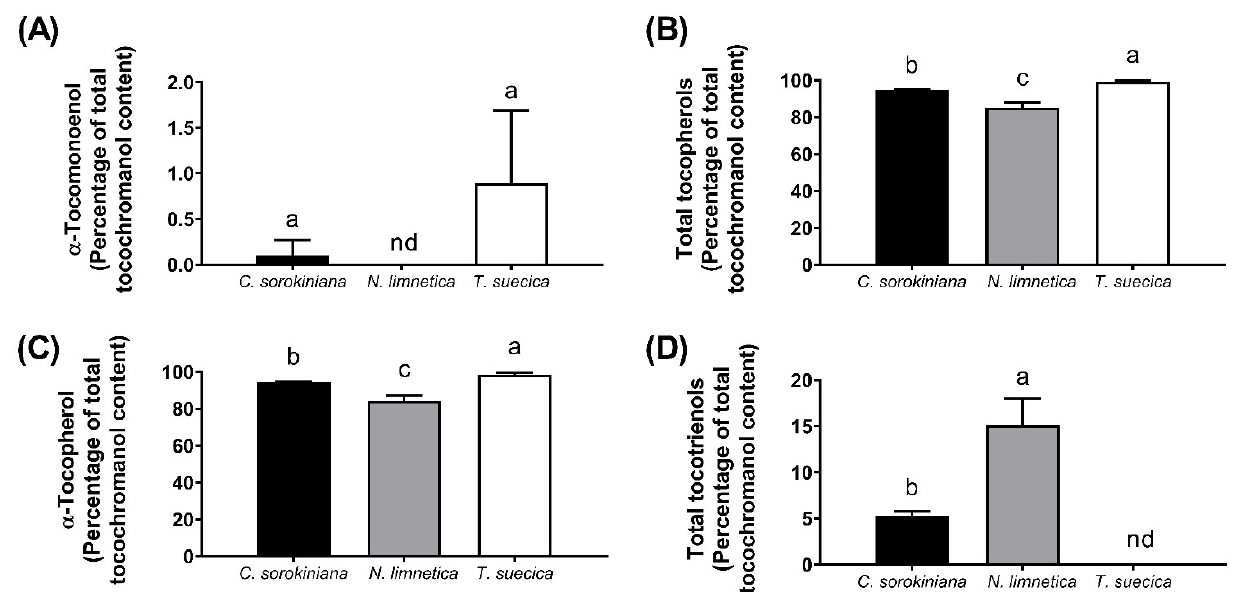
Figure 4. α -Tocomonoenol ( α T1) ( A ), total tocopherols (T) ( B ), α -tocopherol ( α T) ( C ), and total tocotrienols (T3) ( D ) content expressed as percentage of total tocochromanol content for Chlorella sorokiniana , Nannochloropsis limnetica , and Tetraselmis suecica , as determined by HPLC-FLD. Values are presented as arithmetic mean ± standard deviation ( n = 6). Bars not sharing a superscript letter are significantly different (ANOVA, α = 0.05). Bars with “nd” refer to congeners not detected by HPLC- FLD.